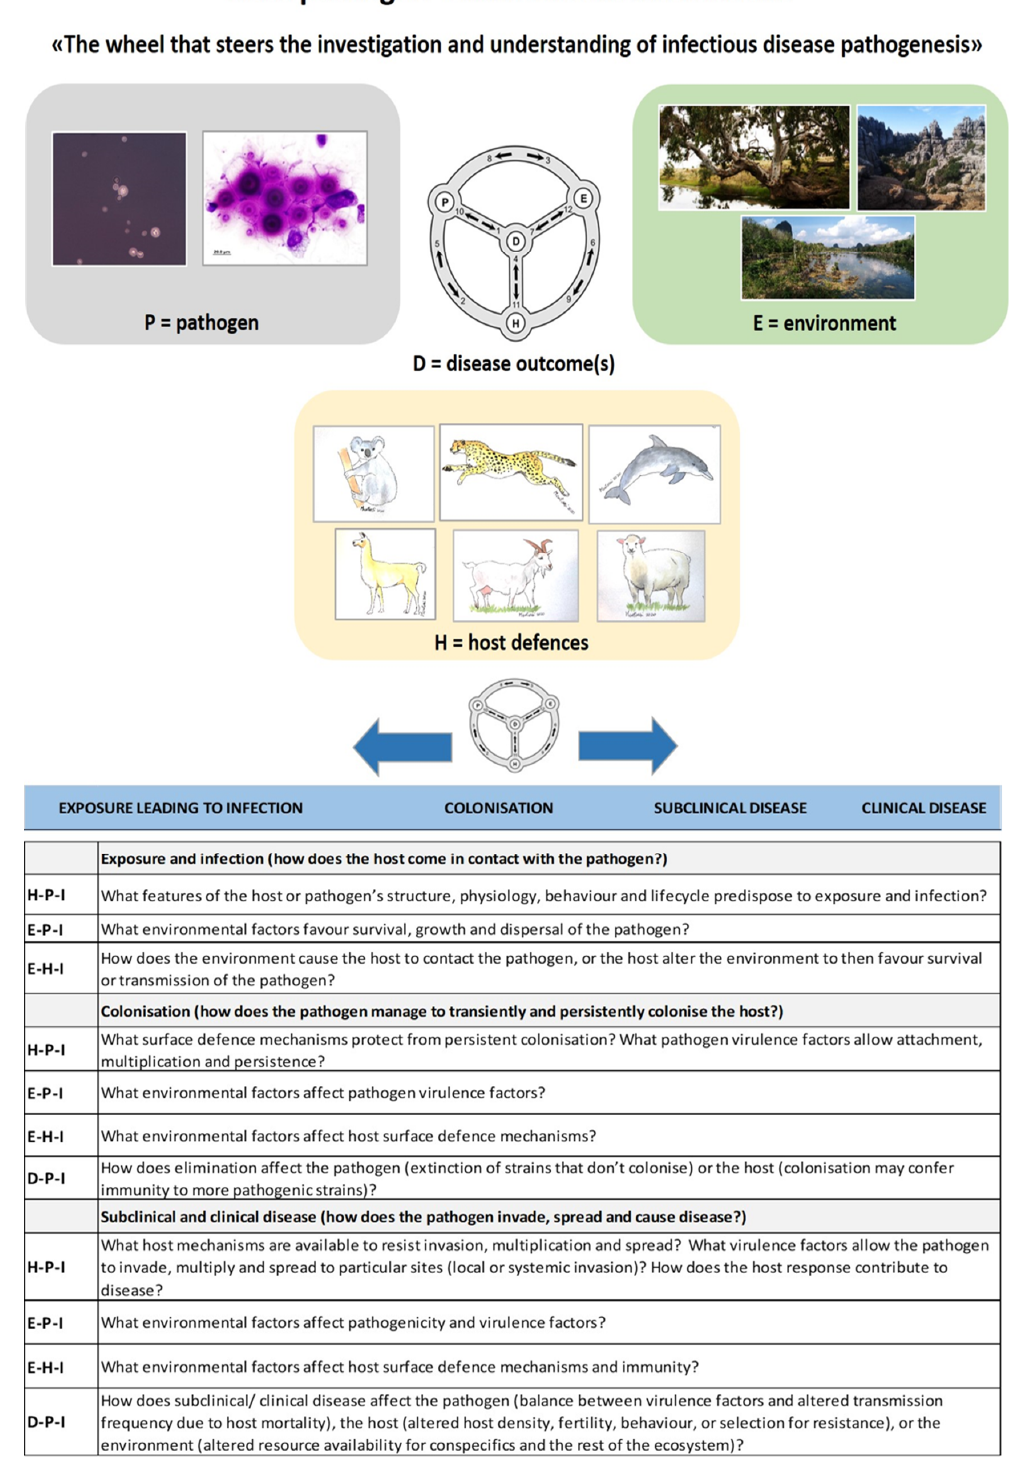
Figure 5. Host–pathogen–environment interactions: the wheel that steers investigation and understanding of infectious disease development. Interactions may enhance or ameliorate disease. P , pathogen; H , host defenses; E , environment; D , disease outcome (subclinical or clinical effect on the host). For any potential pathogen, the interaction of host, pathogen and the environment determine where on the disease–outcome continuum the relationship will lie. This integration of concepts gives rise to a template of questions and generates hypotheses for use in investigating wildlife disease (adapted from ideas developed by Emeritus Professor Paul